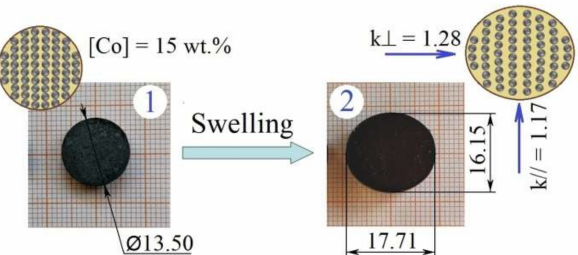
Figure 18. Demonstration of swelling anisotropy of a sample of Co-filled pHEMA-gr-PVP copolymer ob- tained by polymerization filling in a magnetic field: 1—Dry sample; 2—Equilibrium swollen